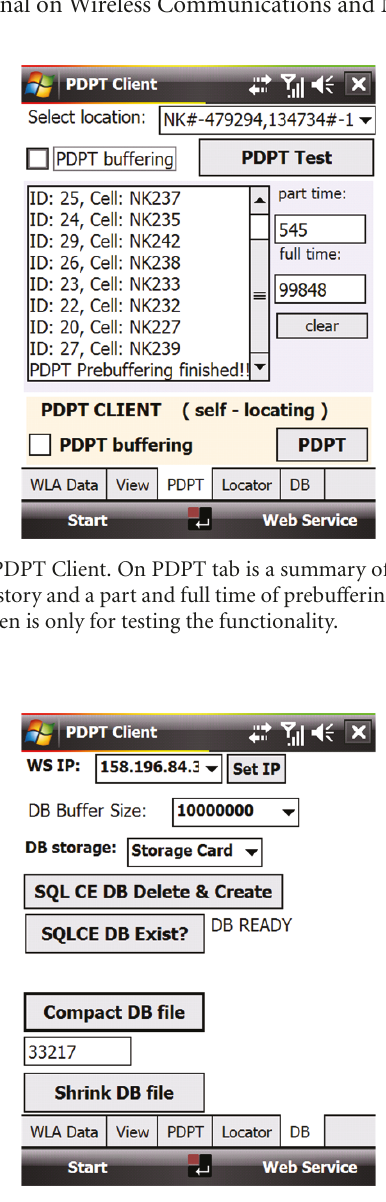
Figure 8: PDPT Client. The DB tab allows managing all necessary things from creation of database to Compact or